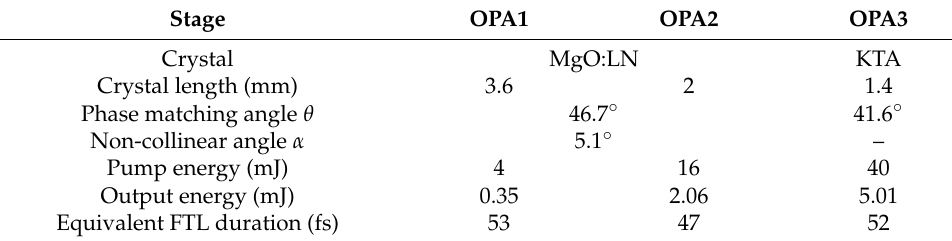
Figure 4. Spectra and energy output of proposed few-cycle, few-mJ-level OPCPA chain: input ( shaded ), OPA 1 ( dotted red ), OPA 2 ( dashed red ), and OPA 3 ( blue ). The final 5 mJ output represents a net 8.4% pump to signal conversion efficiency and a net gain of 100 × , with an equivalent 52 fs FTL pulse length. Table 3. Amplification parameters and output values of the proposed three OPCPA stage